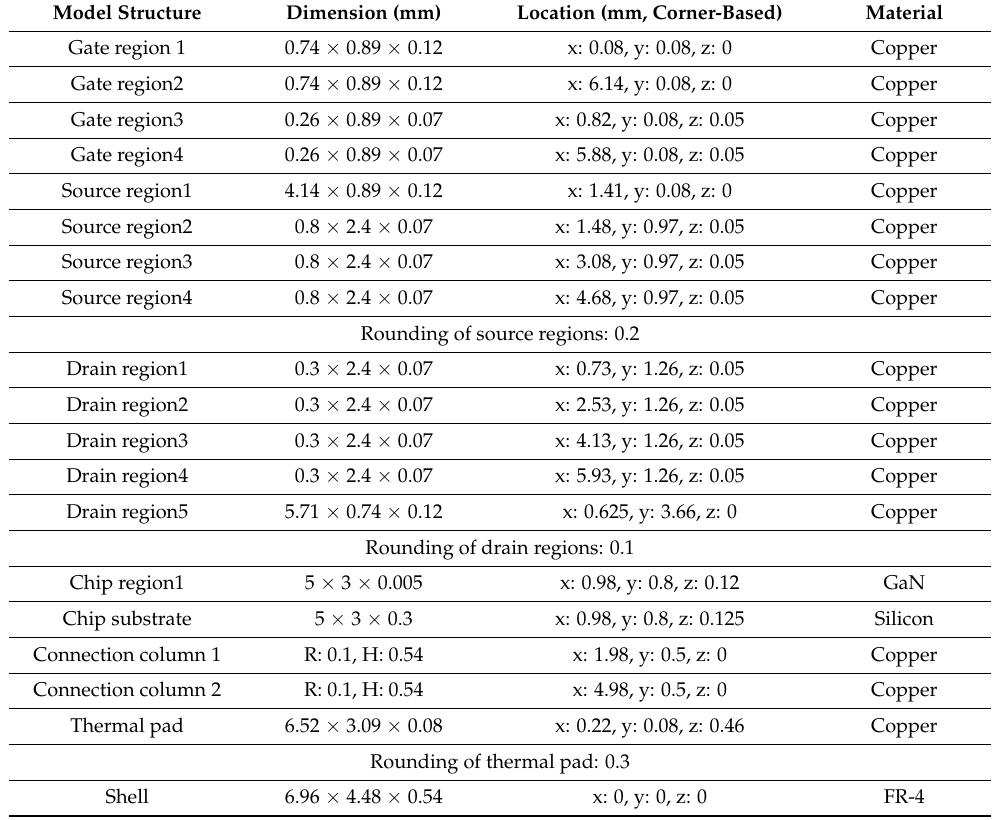
Table 1. Model dimension, location and material. Model